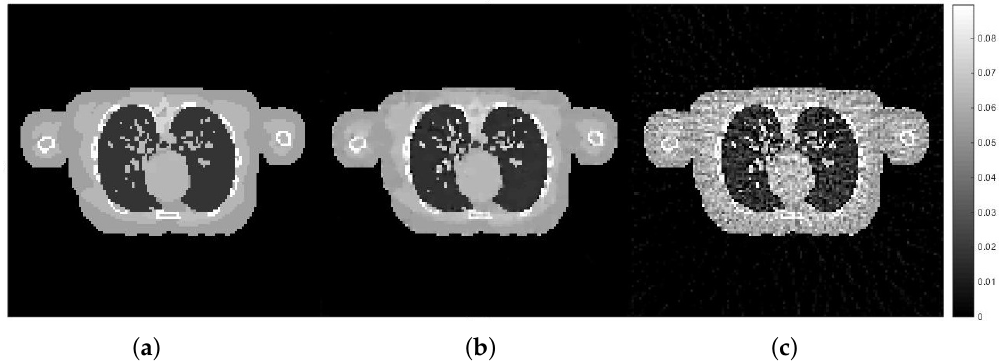
Figure 11. The reconstruction results of the experiment with third dataset: female phantom : ( a ) exact female phantom image, ( b ) with the best hyper-parameters using the proposed Hedge-based approach with the first dataset ( ng = 10, (cid:101) = 0, β = 1, β red = 0.99, δ = 0.0748), ( c ) with random hyper-parameters ( ng = 1, (cid:101) = 500, β = 1, β red = 0.99, δ = 0.0748)